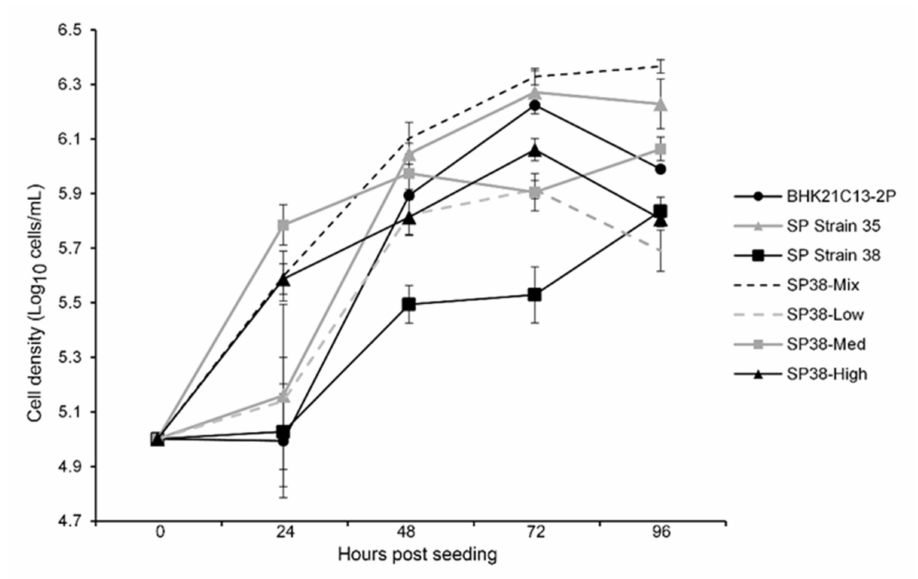
Figure 4. Comparative growth analysis of parental and recombinant suspension BHK-21.